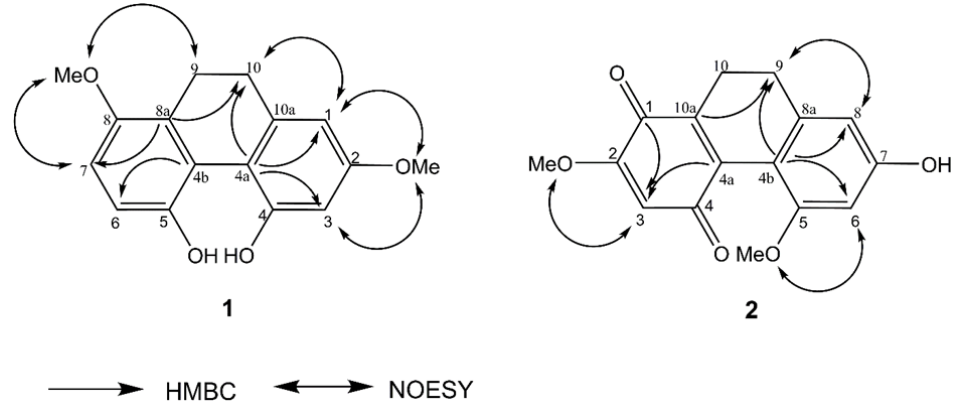
Figure 2. Selected HMBC and NOESY correlations of 1 and 2 . Compound 2 , a red amorphous solid, was analyzed for C 16 H 14 O 5 from its [M − H] − at m/z 285.0752 (calcd for C 16 H 13 O 5 285.0763). The IR spectrum showed absorption bands